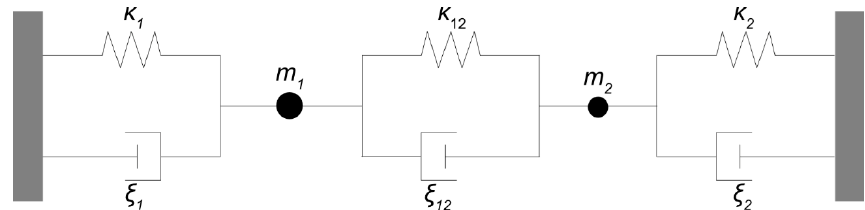
Figure 11. Mechanical representation of a TSM resonator operated at increased oxide electrode conductivity.